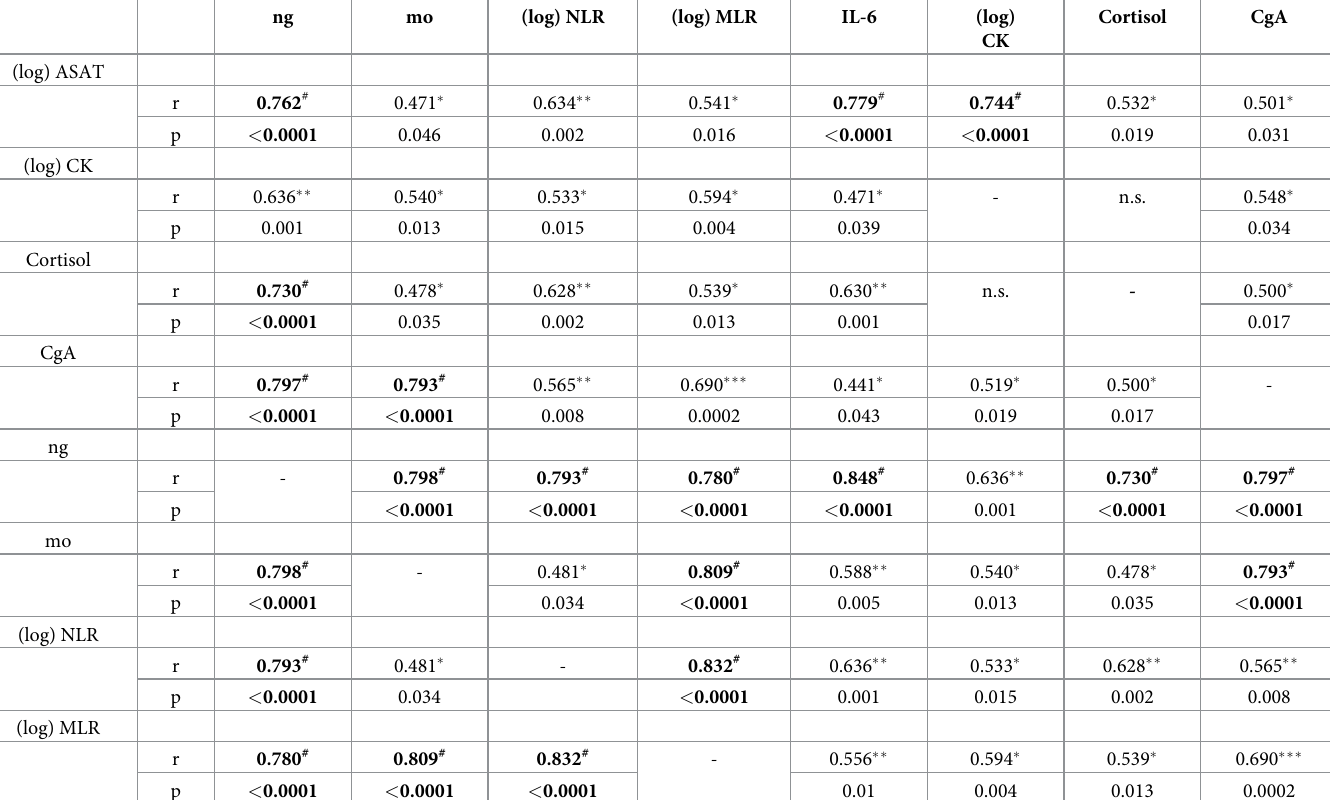
Table 2. Significant multivariate correlations between inflammatory markers, cell damage markers, and stress markers on the next day following